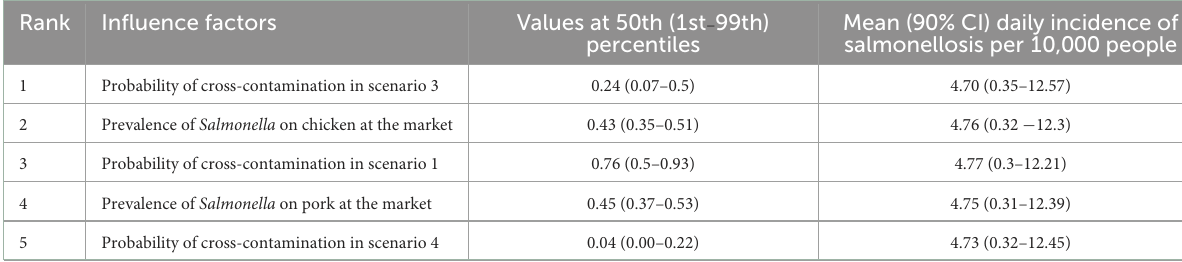
TABLE 5 Sensitivity analysis of influence factors on daily salmonellosis incidence due to consuming pork and chicken